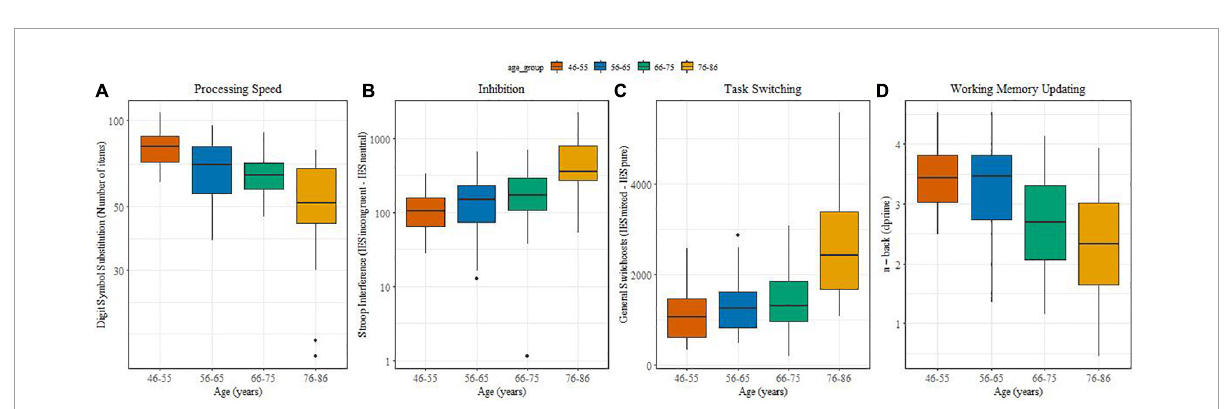
FIGURE2 (A–D) (boxplots): Associations between age and performance on cognitive measures. (A) Processing speed; (B) Inhibition; (C) Task switching; (D) Working memory updating.